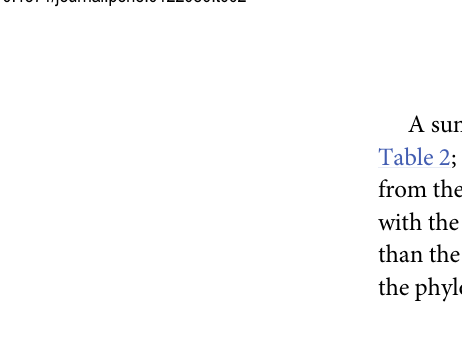
A summary of the most prominent diagnostic characters for these taxa is presented in Table 2; information on biomes in this table follows Schrire and co-workers [30]. It is clear from the morphology that some characters of Oberholzeria fit better with the Crotalarieae than with the Genisteae but there is stronger molecular support for its placement with the Genisteae than the Crotalarieae. This incongruent pattern is also reflected in the different placements in the phylogenies based on analyses of plastid and nuclear sequence data. It is therefore difficult